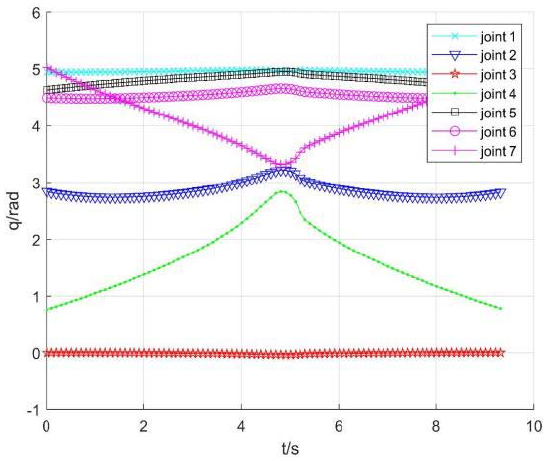
Figure 10. Position of each joint.